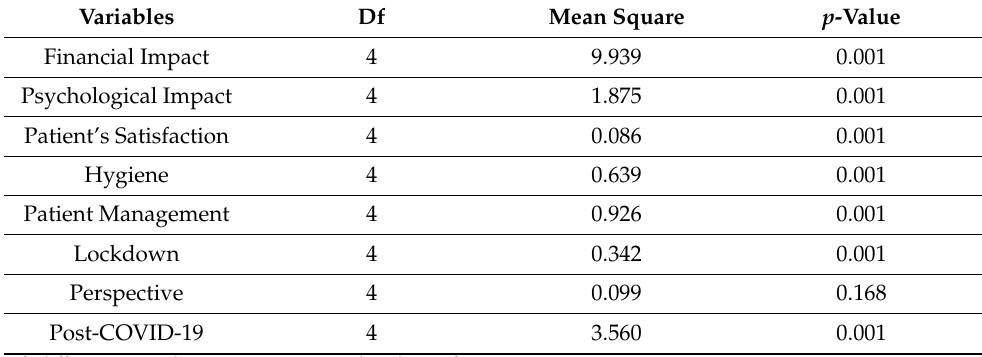
Table 6. Comparison of age with dental domains.